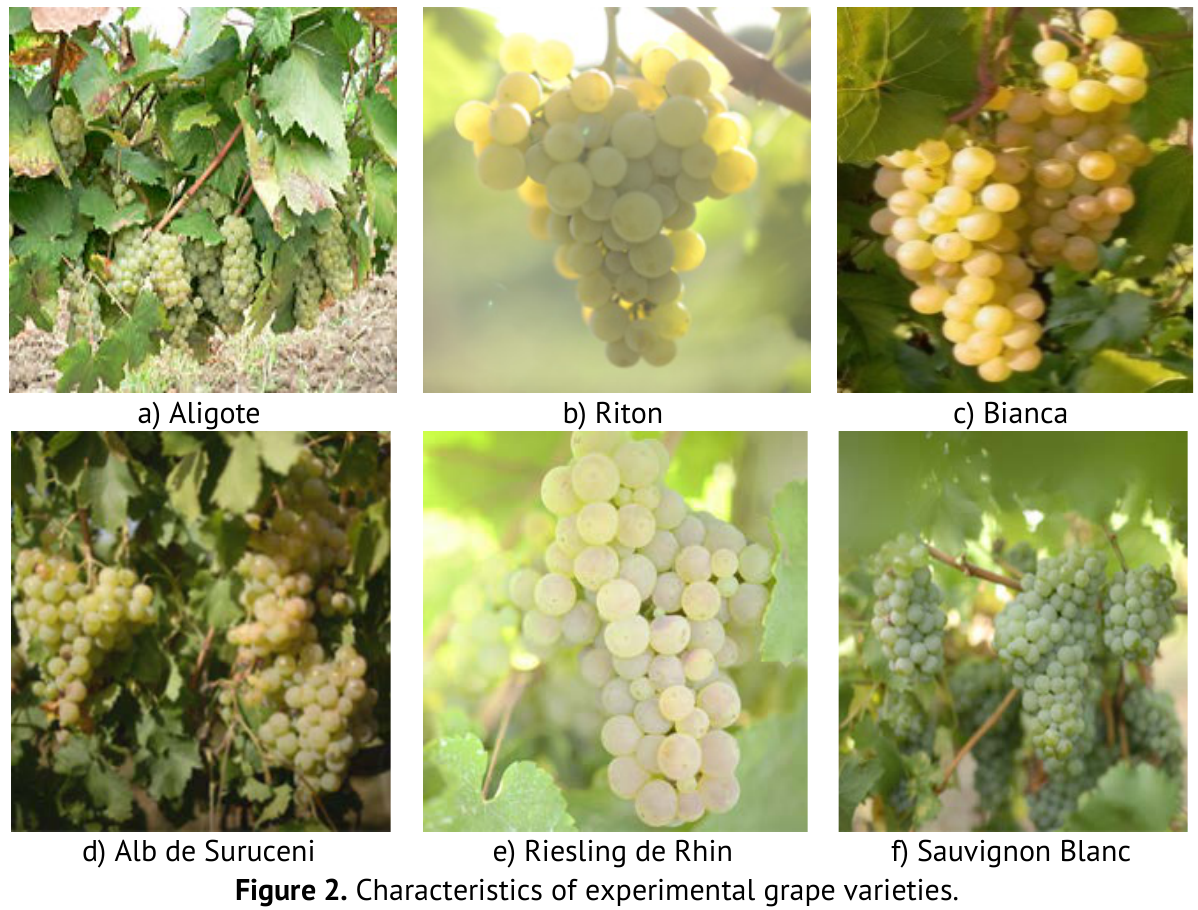
Figure 2. Characteristics of experimental grape